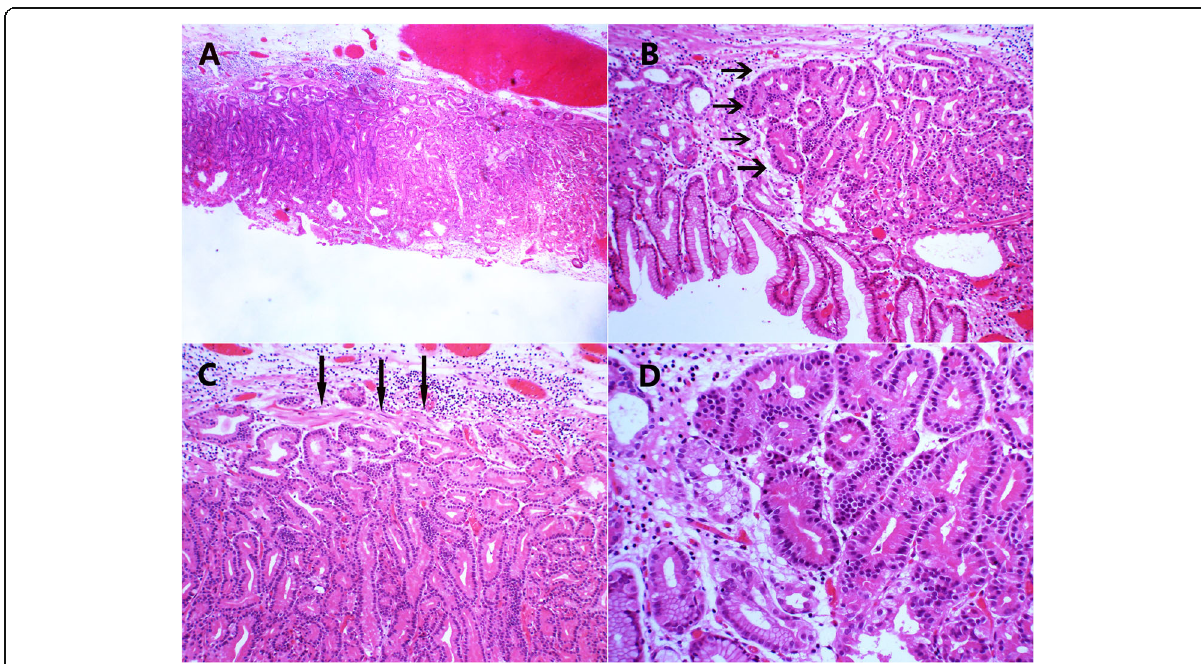
Fig. 4 a Low-power view, the glands of deep mucosa layer are congested (40×). b The lesion had obvious transitional area with the surrounding glands (100×) (arrow). c the gland structure was complex and similar to the fundic glands, tumor cells broke through muscularis mucosae and invaded into submucosa (200×) (arrow). d The atypia of tumor cells was mild